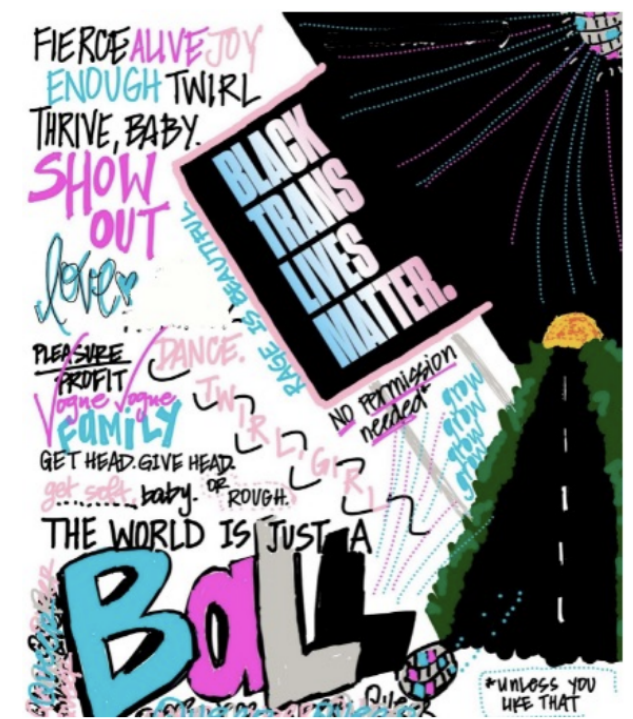
IMAGE 4: FACILITATOR EXAMPLE OF FREEDOM